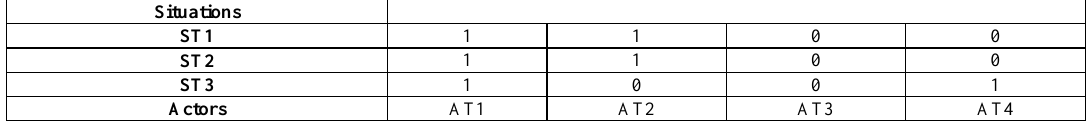
Table 8. Cross interaction binary matrix for situation and actors in binary form.